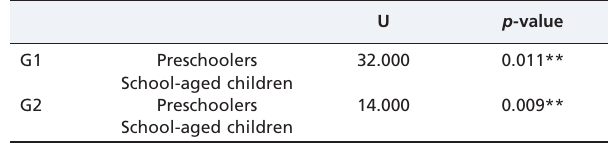
Table 4 - Comparisons by age group of the average period of CV U